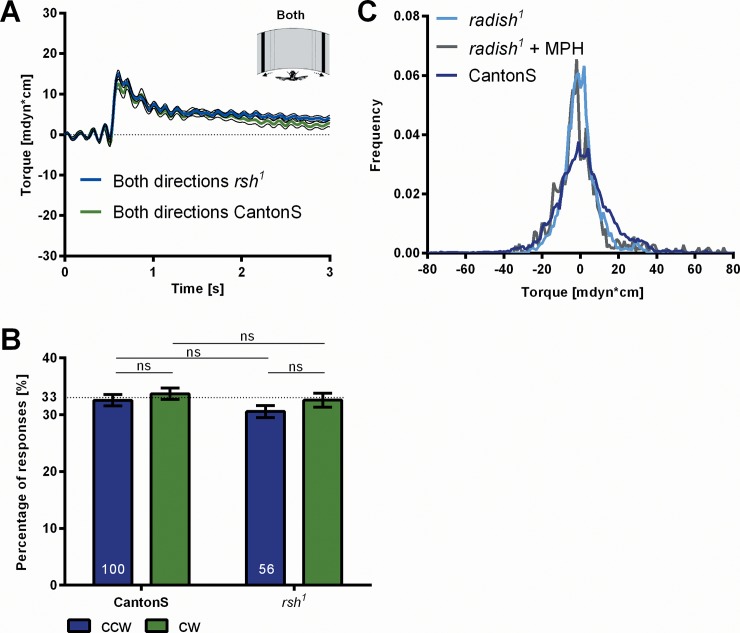
Flight behavior of mutant rsh1.(A) Average time traces of CantonS and radish1 torque responses to the displacement of both stripes (‘Both’, N = 21 and N = 35). Responses of CantonS have a slightly smaller amplitude than those of radish1. (B) Response frequencies of radish1 and CantonS show no significant differences. (C) Normalized histograms of yaw torque generated by the flies within 1s intervals between test trials. Torque modulations are slightly reduced in radish1 as compared to CantonS (N = 35 and N = 100). The reduction of torque modulation remains unaltered by MPH treatment of radish1 flies (N = 16). Error bars are SEMs (*P < 0.05, **P < 0.01, ***P < 0.001).